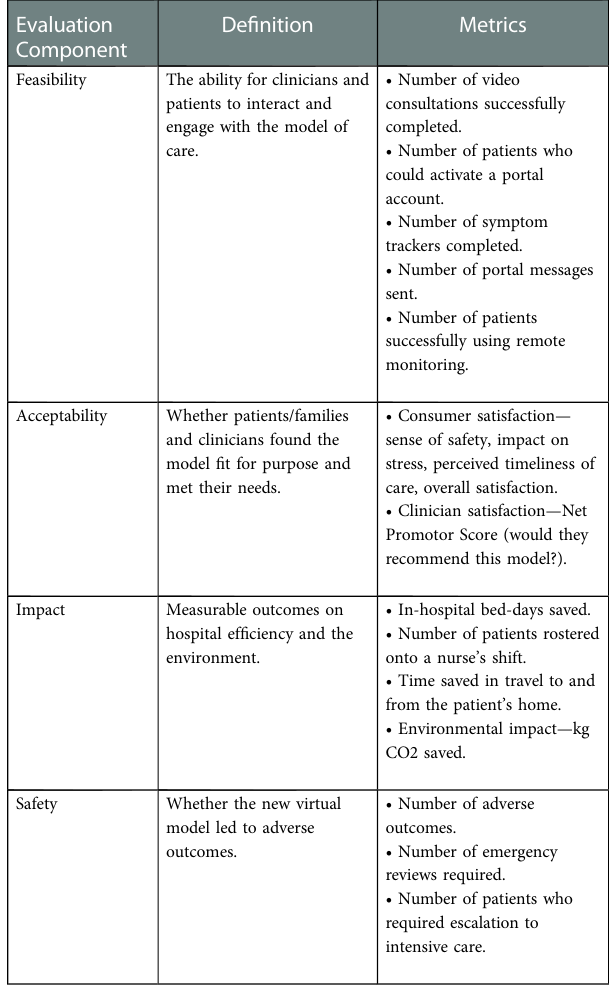
De fi nition Metrics